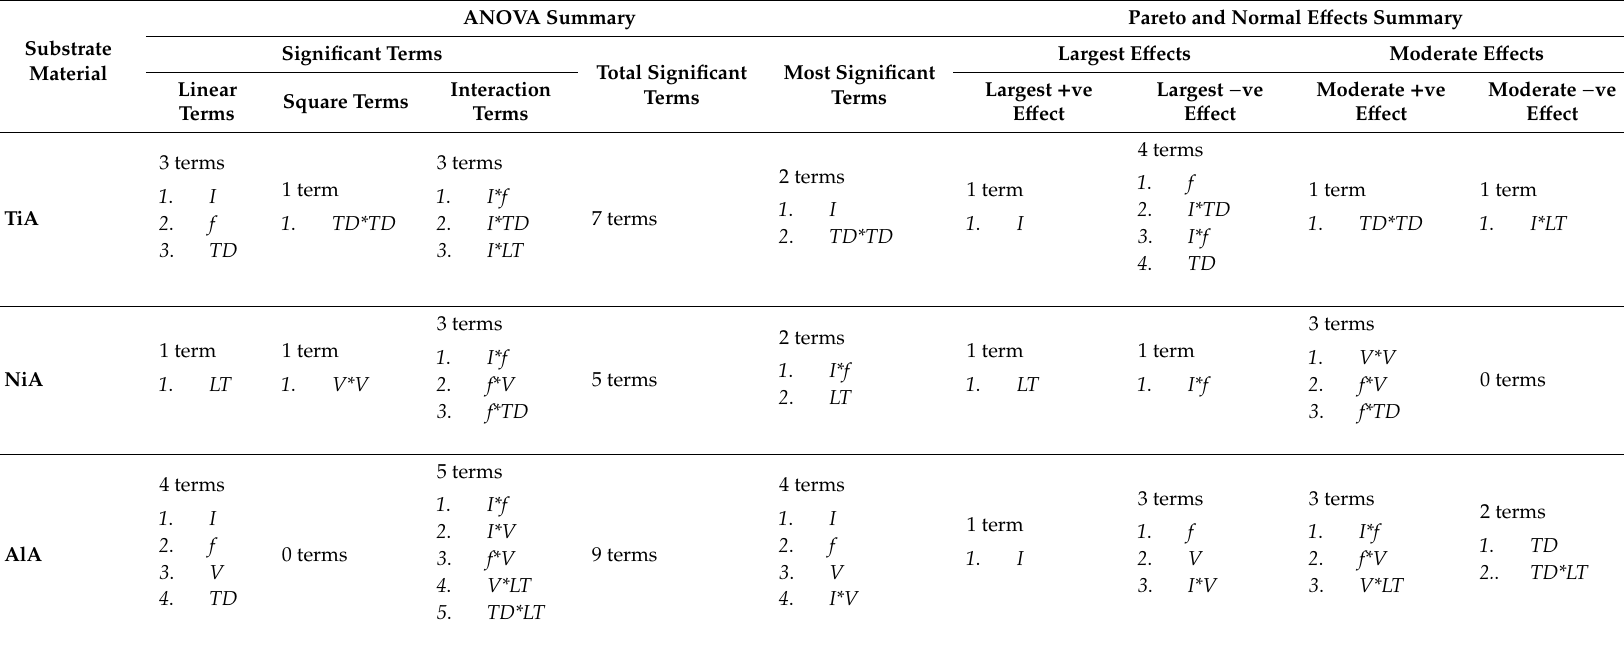
Table 5. ANOVA summary for surface